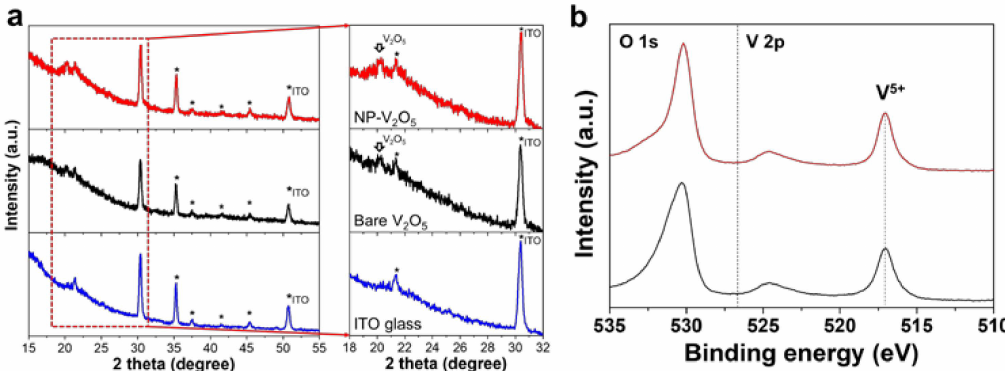
Figure 2. ( a ) X-ray di ff raction (XRD) patterns of bare ITO glass, bare V 2 O 5 on ITO glass, and NP-V 2 O 5 on ITO glass prepared using 40 mM PEG. The peaks denoted by asterisk correspond to ITO glass; ( b ) V 2p XPS spectra of bare V 2 O 5 on ITO glass, and NP-V 2 O 5 on ITO glass prepared using 40 mM